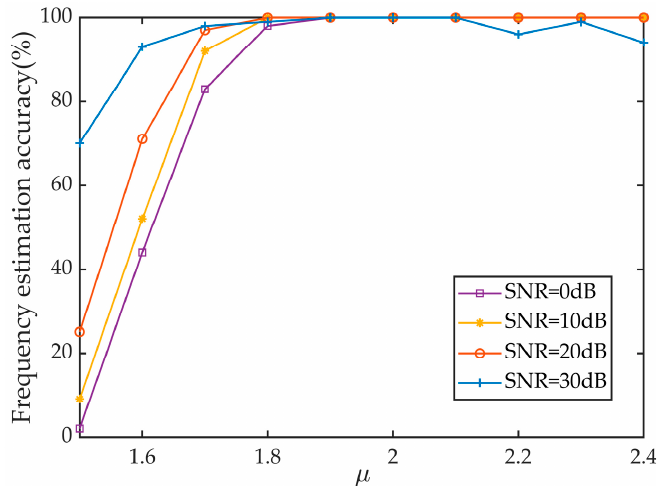
μ Figure 8. The effect of and SNR on the frequency estimation accuracy. Figure 8. The effect of µ and SNR on the frequency estimation accuracy. Figure 8 illustrates that when µ is less than 1.9, the frequency estimation accuracy is proportional to µ . When µ is between 1.9 and 2.1 and the SNR is greater than 0 dB, the frequency estimation accuracy can reach 100%; when µ is greater than 2.1 and the SNR is 0 dB, the frequency estimation accuracy starts to decrease. The results show that either µ being set either too high or too low reduced the frequency estimation accuracy. Therefore, the kurtosis threshold ( µ ) was set to 2.0. The parameter µ was set to 2.0, and the SNR was set to 0 dB. The parameter α was selected sequentially in the range of [ 0, 4 ] at intervals of 1. The p was processed by the zero-setting method and the averaging method, and 100 Monte Carlo tests were conducted. The results are shown in Figure 9.